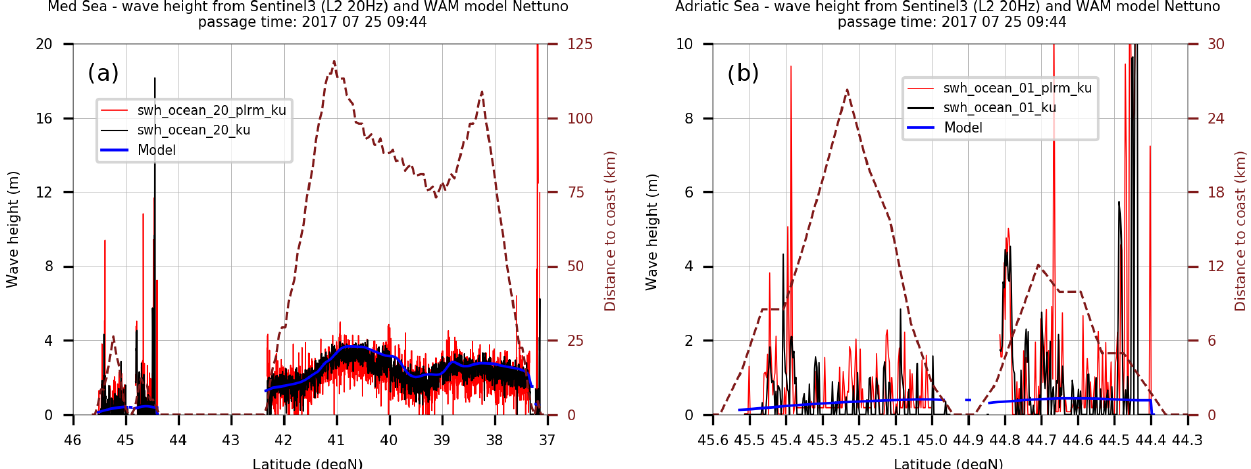
Figure 9. As in Fig. 8, but for the 20Hz altimeter data. Panel (a) represents the full pass, and panel (b) represents the Adriatic Sea section (see Fig. 8 for